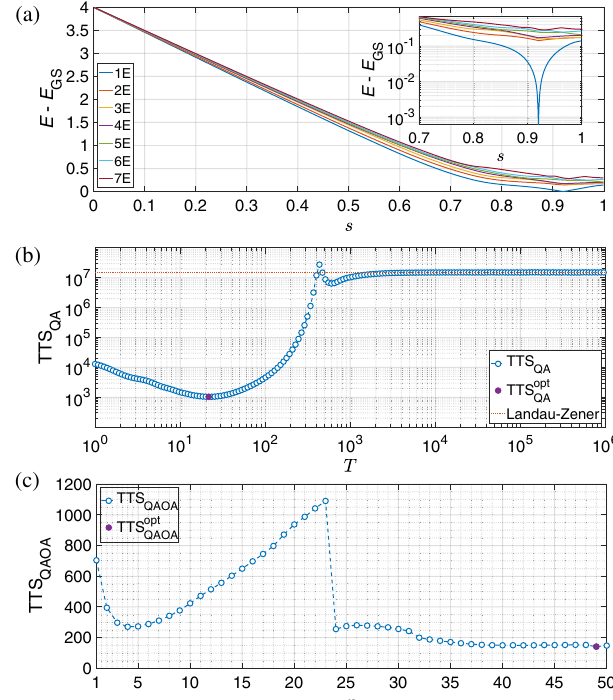
FIG. 12. (a) Energy spectrum of low excited states (measured from the ground state energy E ) along the annealing path for GS the graph instance given in Fig. 6(b). Only states that can couple to the ground state are shown, i.e., states that are invariant under Q N σ x the parity operator P ¼ i . The inset shows the energy gap i ¼ 1 from the ground state in the logarithmic scale. (b) Time to solution for the linear-ramp quantum annealing protocol, TTS , QA for the same graph instance. The TTS in the long time limit follows a line predicted by the Landau-Zener formula, which is independent of the annealing time T . (c) The TTS for the QAOA at each iteration depth p